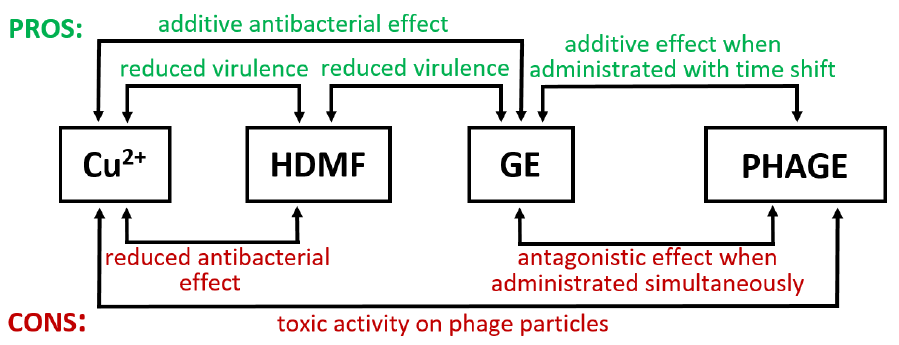
Figure 9. The pros and cons of Cu 2+ , HDMF, GE, and lytic phages combinations. The best additive effect was obtained for the Cu 2+ –GE mixture. The combination of GE with phages can be beneficial but not when administrated simultaneously. HDMF applied with Cu 2+ or GE reduces the overall virulence potential of P. aeruginosa PAO1. Furthermore, HDMF neutralizes cupric ion toxicity on the cell-viability level. To conclude, the